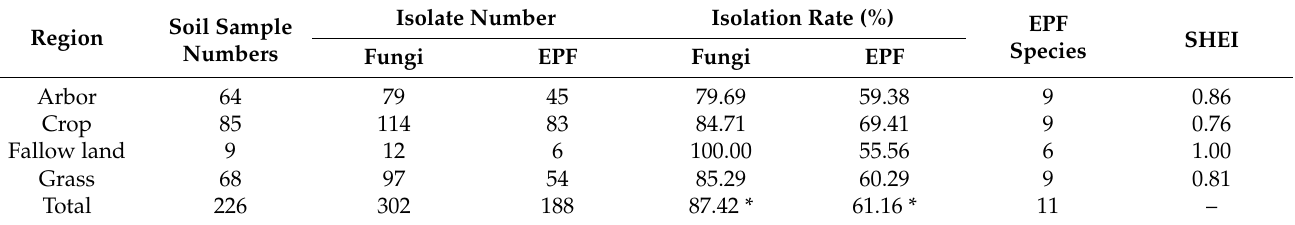
Table 3. The fungi isolation and biodiversity of different samples.